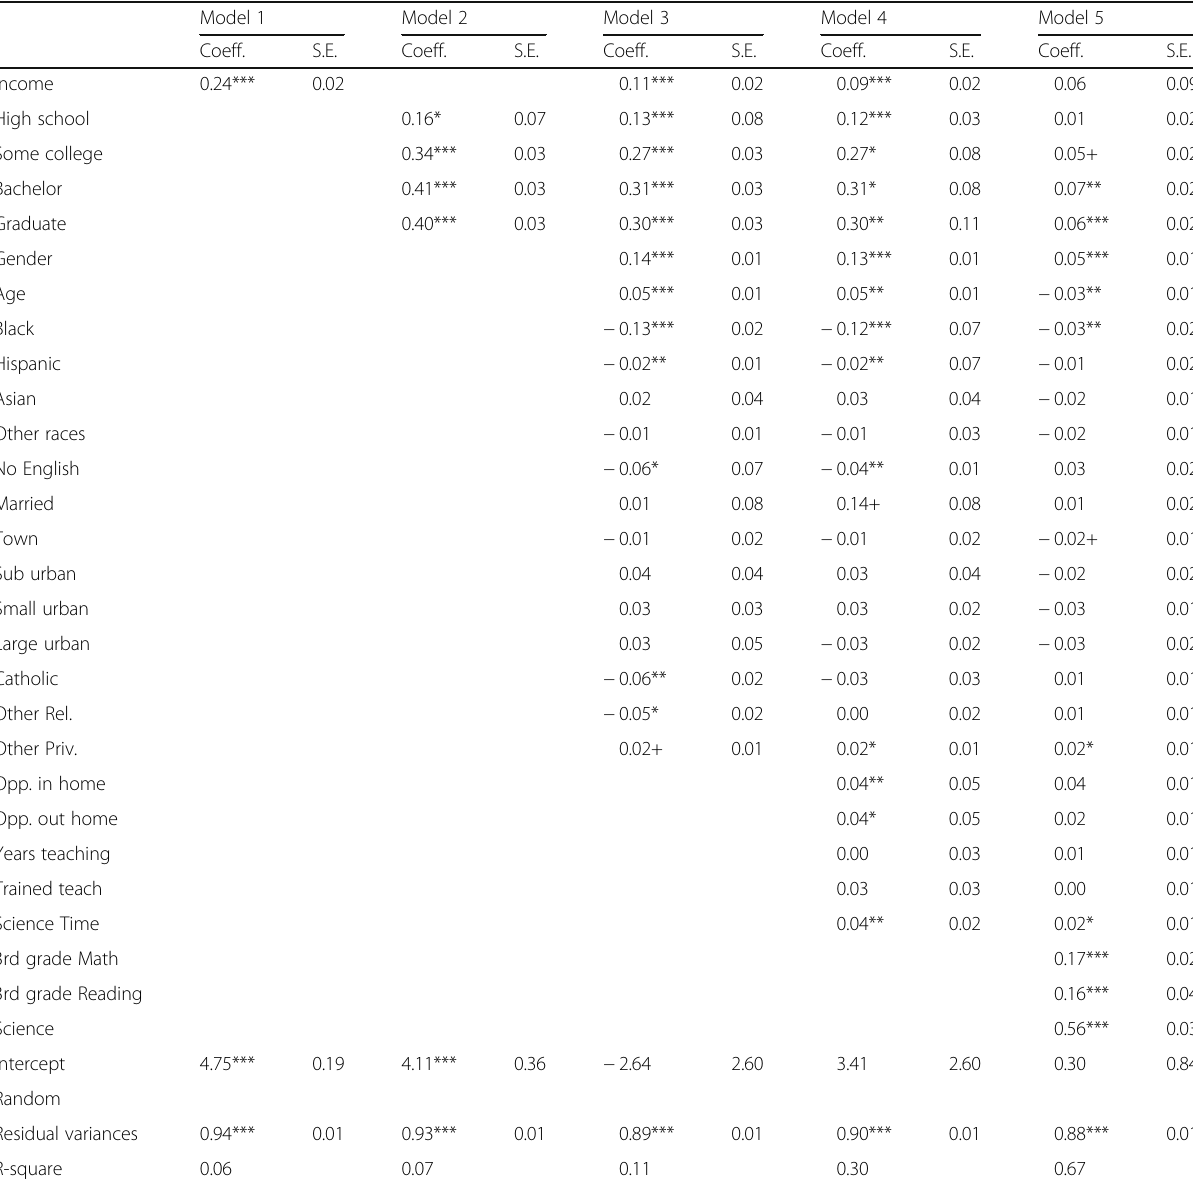
Table 3 Results for science at fifth